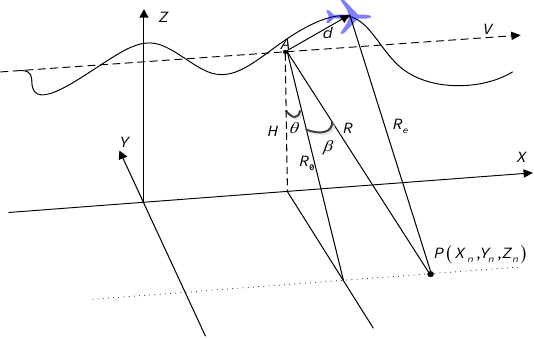
Figure 2. Radar motion displacement model of TOPS SAR.